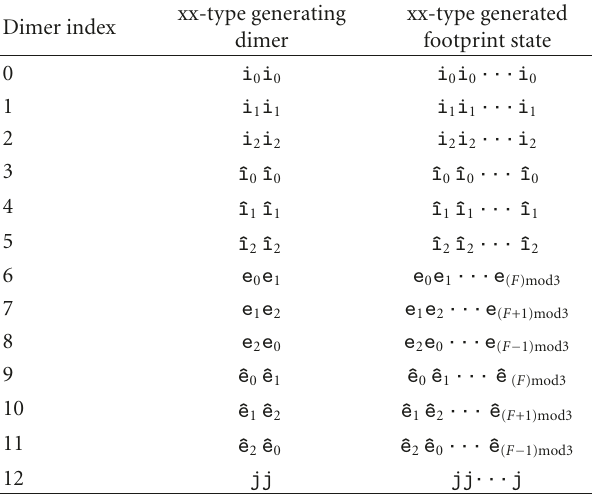
Table 5: All 13 xx-type footprint states generated by the xx-type